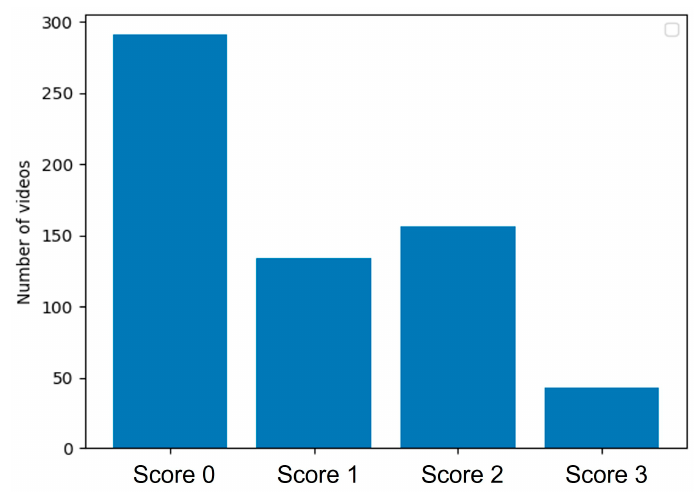
Figure 2. Dataset classes distribution.